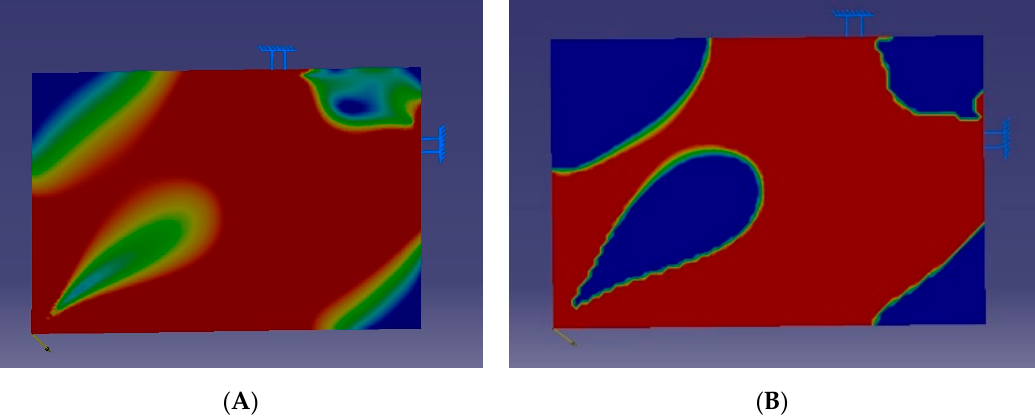
Figure 13. ( A ) Build envelope developed stresses. ( B ) Threshold filtered stress domain.